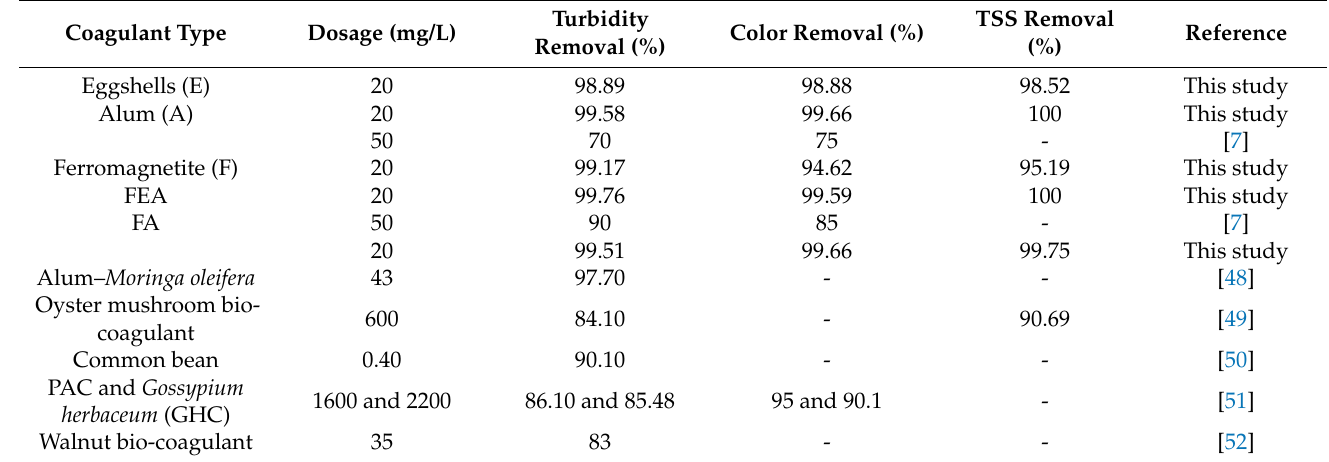
Table 3. Different coagulants used in wastewater